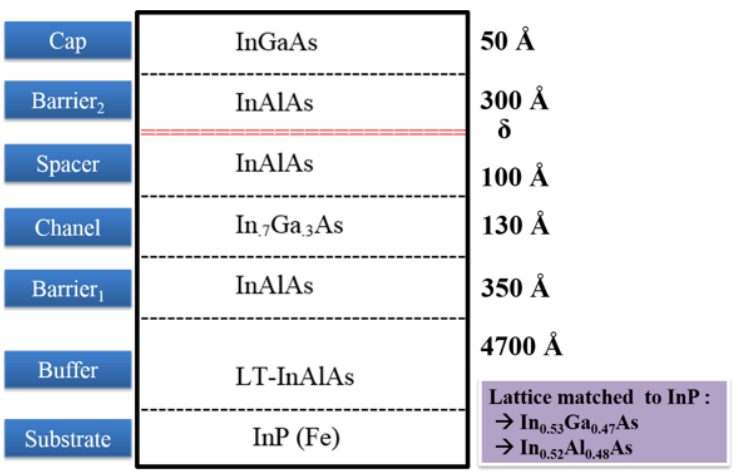
Figure 2. XMBE56 (improved pHEMT incorporating LT-In 0.52 Al 0.48 As buffer) epitaxial layer grown on in-house RIBER V100 MBE (thickness not to scale). Table 1. XMBE171 and XMBE56 band energies (Eg) and band gap difference ( ∆ Eg).